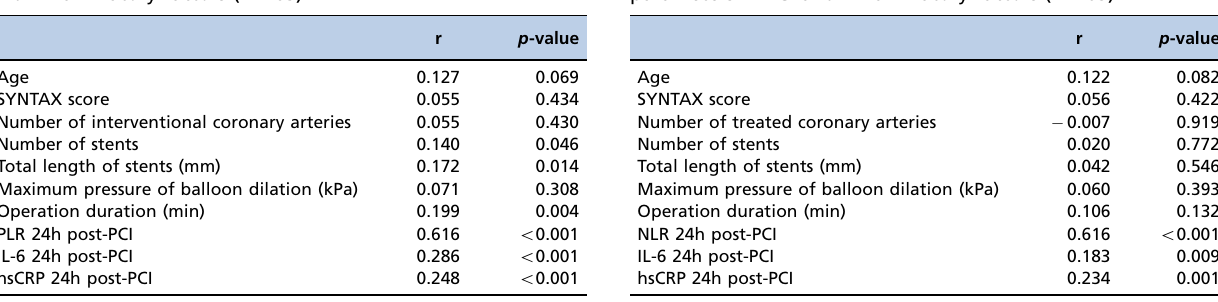
Figure 2 - ROC curves of inflammatory biomarkers for predicting MACE after PCI. Abbreviations: PCI, percutaneous coronary intervention; MACE, major adverse cardiac events; ROC, receiver operating characteristic. Table 5 - Correlations between NLR and age, parameters in PCI Table 6 - Correlations between postoperative PLR and age, and inflammatory factors (n=205). parameters in PCI and inflammatory factors